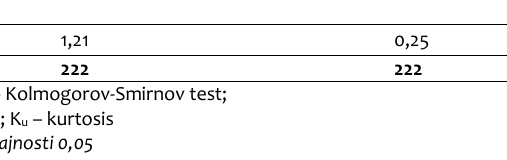
U Tabeli 3. prikazani su osnovni statistički pokazatelji za identifikovane faktore, na osnovu kojih uočavamo da studenti imaju pozitivnu procenu socijalne uključenosti (M=50,31) i neutralnu